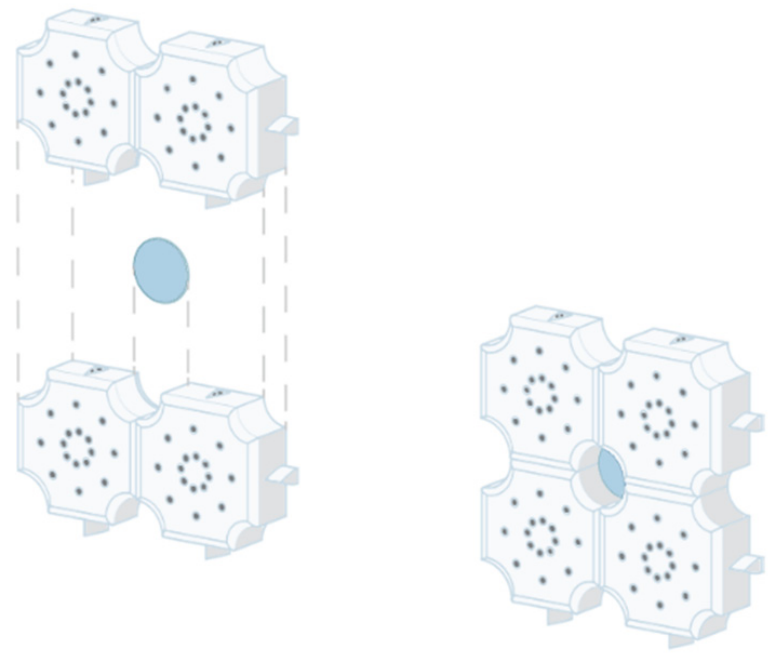
Figure 1. Conceptual scheme of the 4-blocks component (with PDI behaviour) that creates the place where to insert the plate (in blue).